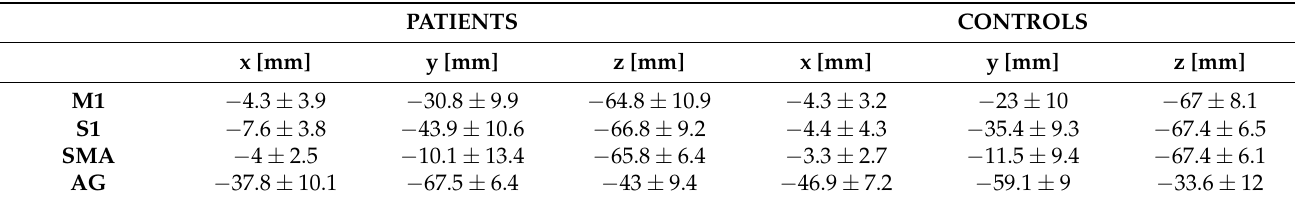
Table 3. Mean ROI coordinates of patients and controls ± standard deviation. M1: primary motor cortex; S1: primary somatosensory cortex; SMA: supplementary motor area; AG: angular gyrus. PATIENTS CONTROLS x [mm] y